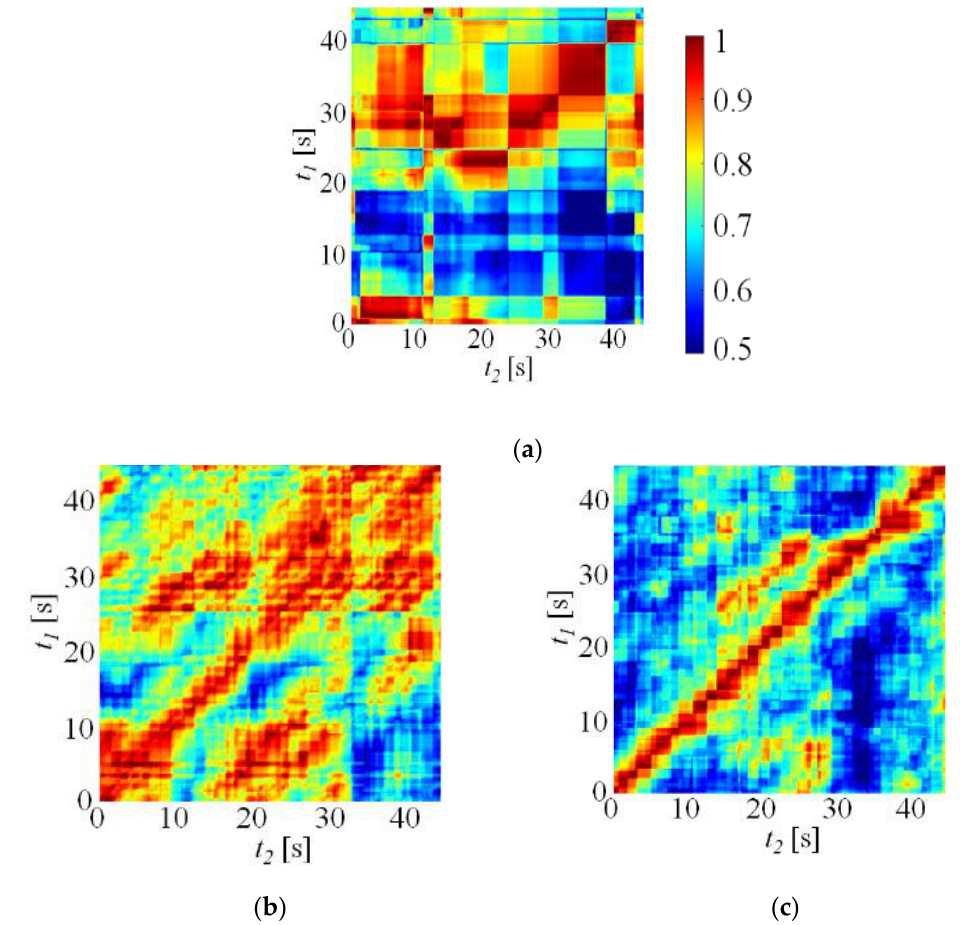
Figure 11. Cross-correlations of heat fluxes at 1b and 7b ( a ) Q ele = 0.5 W, ( b ) Q ele = 2 W, ( c ) Q ele = 3.5 W.